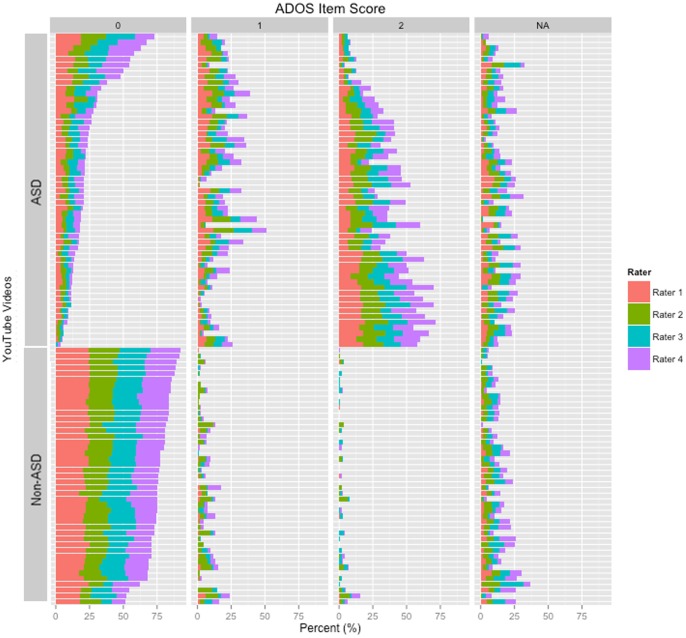
Inter-rater variability among cases previously diagnosed with autism and controls with no known diagnosis of autism.While subjectivity shifts did occur among the four independent raters, these shifts in qualitative judgment did not significantly impact the agreement among the reviewers. Both the inter-rater classification agreement (>90%) and classification accuracy (>95%) were found to be high in this analysis.